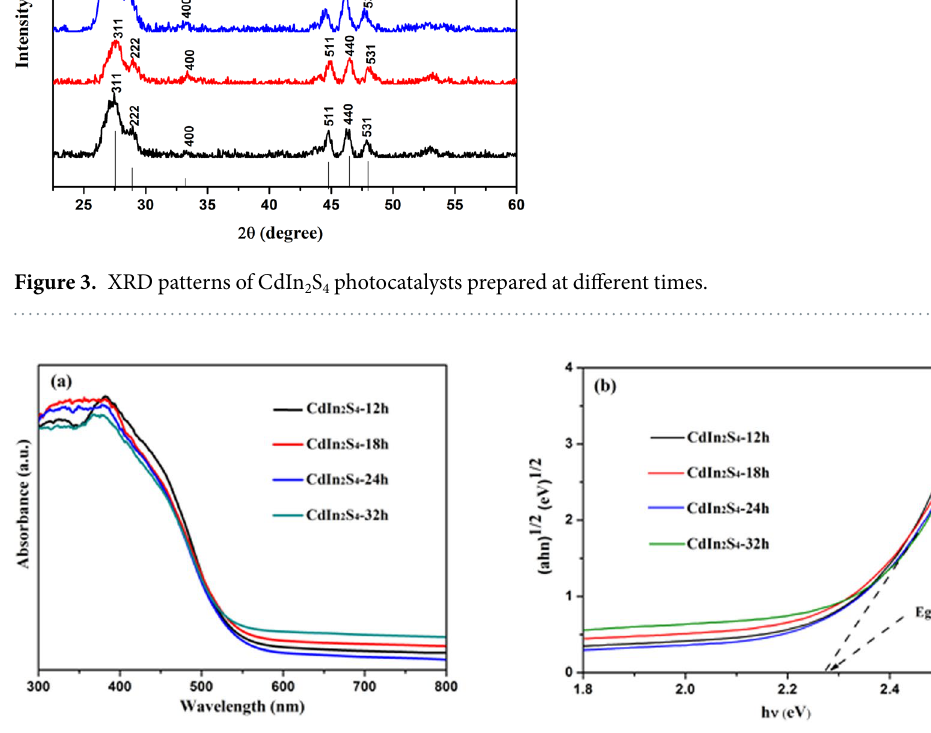
Figure 4. UV-vis diffuse reflectance spectra of CdIn 2 S 4 synthesized at different times ( a ) and band gap energies of CdIn 2 S 4 samples ( b